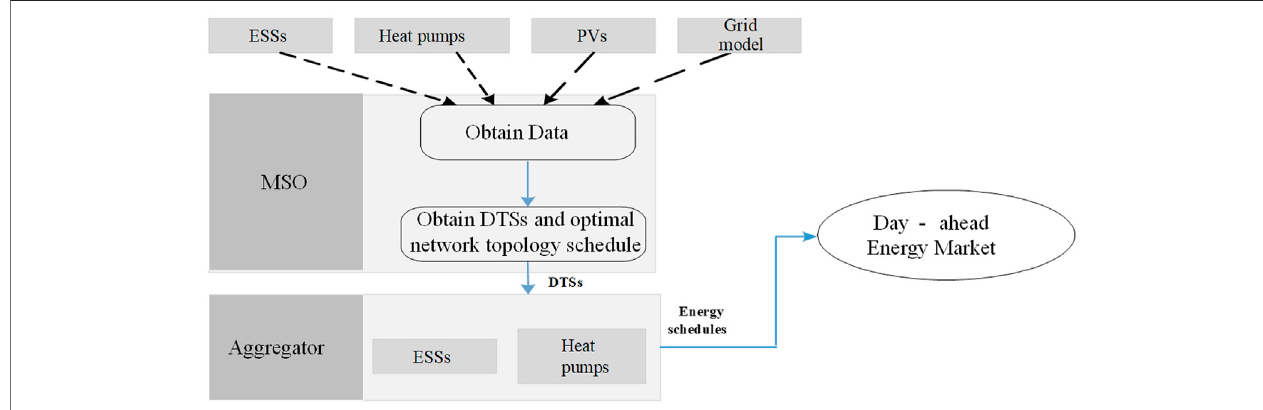
FIGURE 1 | Procedure of the network recon fi guration integrated DTS method for congestion